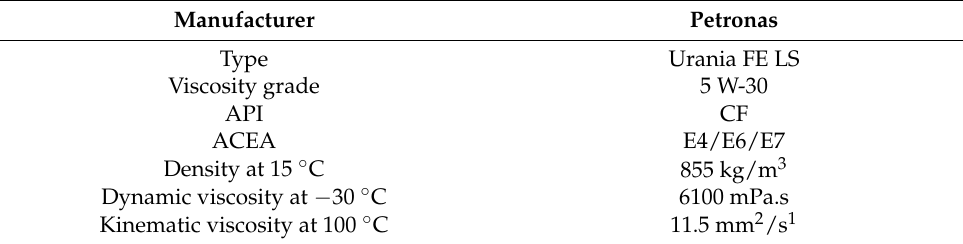
Table 3. Technical specification of engine